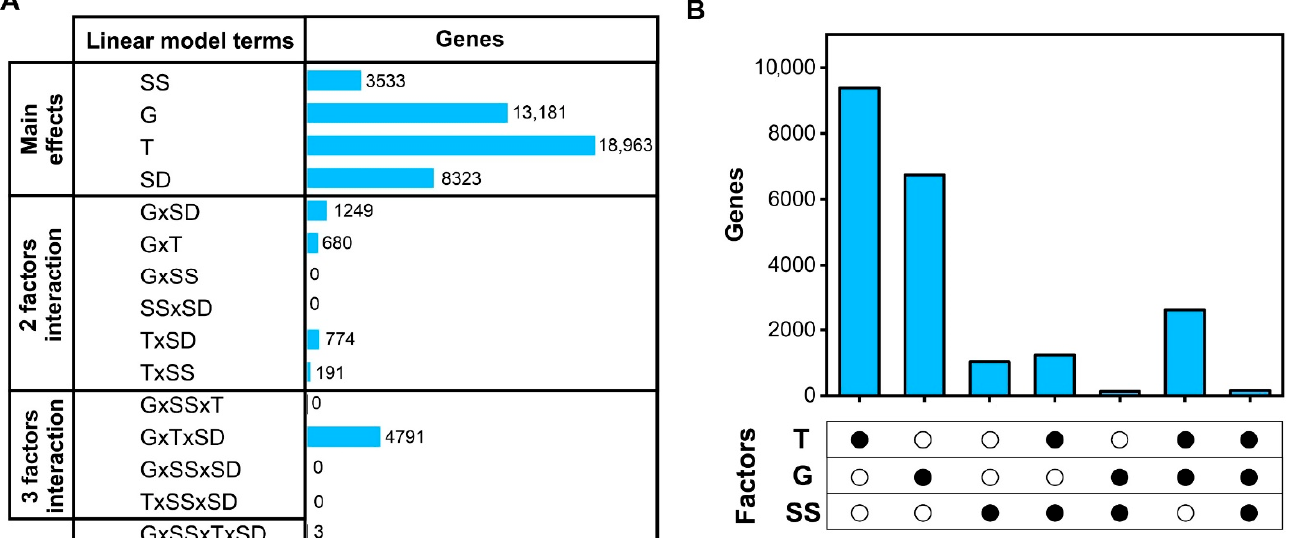
Figure 1. Multivariate analysis of the RNA-seq data obtained from seeds of two rapeseed hybrids grown under different source–sink ratios. ( A ) Multifactorial analysis showing how many genes were regulated by the S–S ratio (SS), genotype (G), developmental time (T), sowing date (SD), and the interaction of these factors (q-value < 0.01). An average of 26 million reads per sample were pseudo-aligned to the Brassica napus reference transcriptome using kallisto [25] and a fully mapped dataset was multivariate analyzed with the sleuth R package [26]. ( B ) An intersection analysis between genes regulated by the S–S ratio (SS), genotype (G), and developmental time (T). Genes significantly affected by SD or factors interactions were discarded from this analysis, which was performed using the SuperExactTest R package [27]. The black points indicate which factors affect the expression levels of the genes shown in the bar diagram.